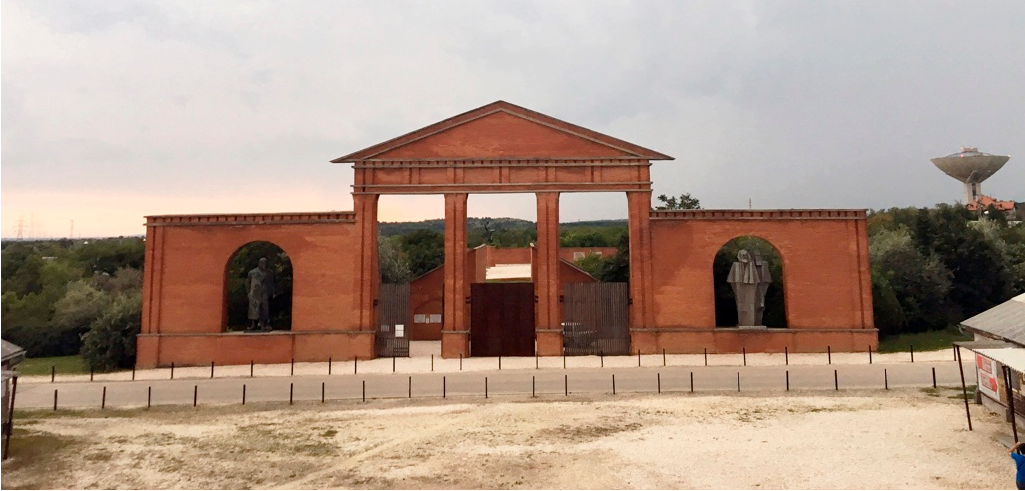
Figure 2. The main entrance to Memento Park in the outskirts of Budapest, marking both temporal and spatial distancing from the contemporary Hungarian national construct. Photo: author, 2018-08-05.